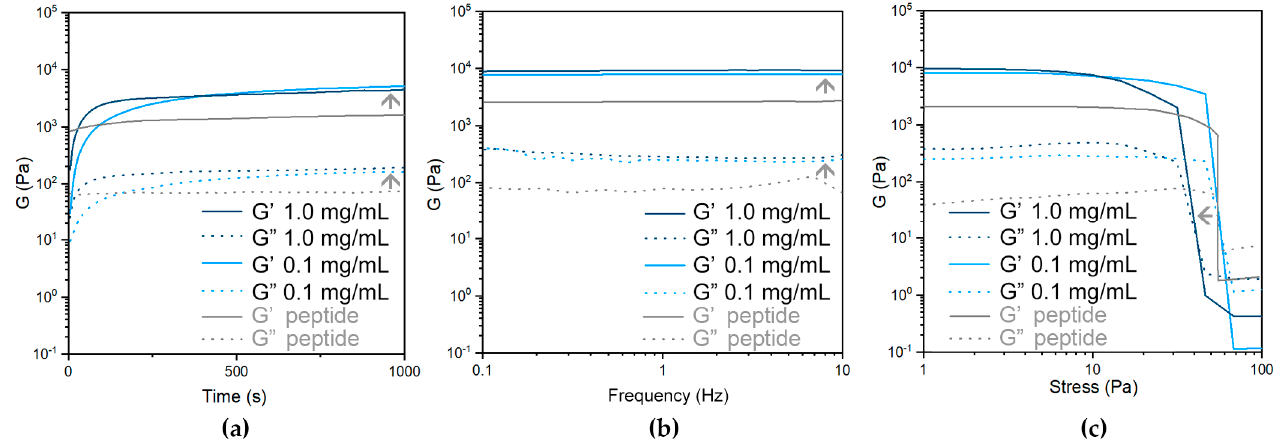
Figure 8. Oscillation-based rheometry of peptide hydrogels without (grey) or with (blue) ox-SWCNTs: ( a ) kinetics; ( b ) frequency ramps; ( c ) stress ramps. Grey arrows indicate ox-SWCNTs’ effects on the viscoelastic properties of the peptide gels.